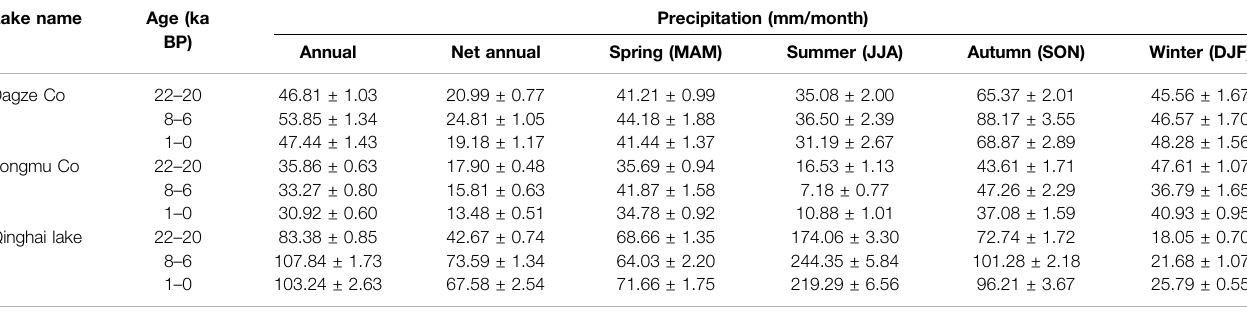
TABLE 2 | Simulated annual precipitation, net annual precipitation and seasonal precipitation based on the TraCE-21 model. The data were downloaded from webpage http://202.195.239.65:8888/, then reanalyzed. Lake name